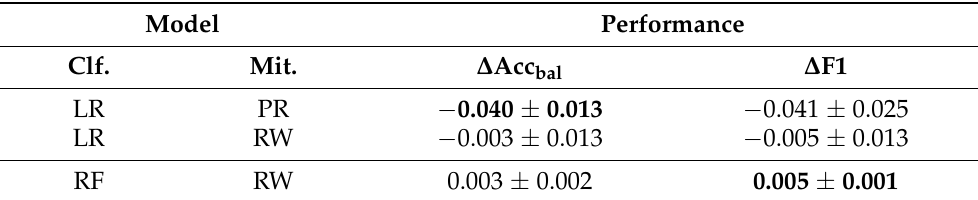
Table 6. Classification metric differences of models with bias mitigators reweighing (RW) and prejudice remover (PR) compared to a baseline without bias mitigation, for logistic regression (LR) and random forest (RF) classifiers. The classification metrics are balanced accuracy (Acc bal ) and F1 score. The errors shown are standard deviations. Differences significant at 95% confidence level are shown in bold .